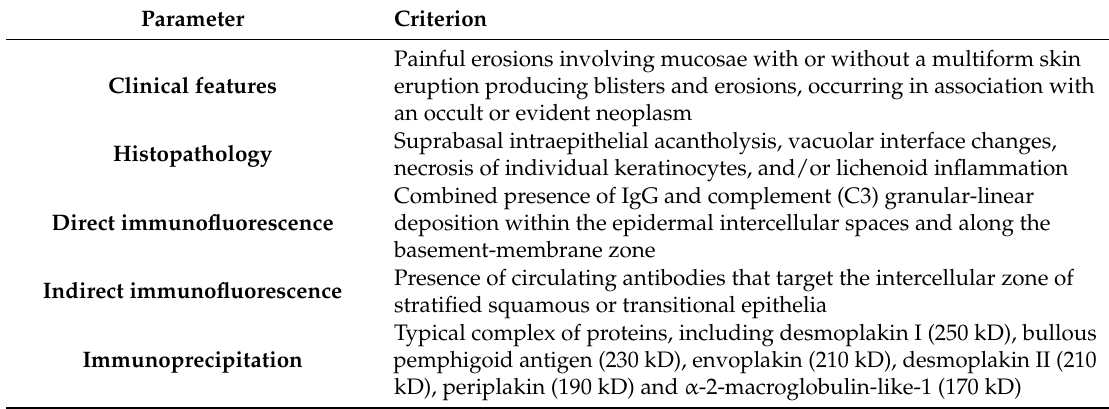
Table 1. Diagnostic criteria [1,12,75].